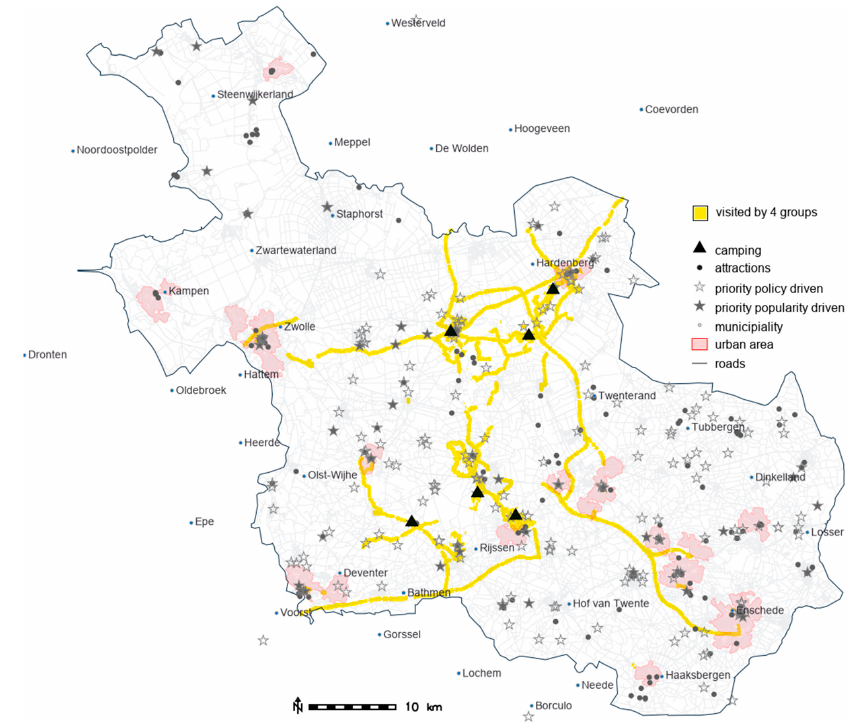
Figure 3. Locations visited by at least one participant from all four groups. Int. J. Environ. Res. Public Health 2023 , 20 , x FOR PEER REVIEW